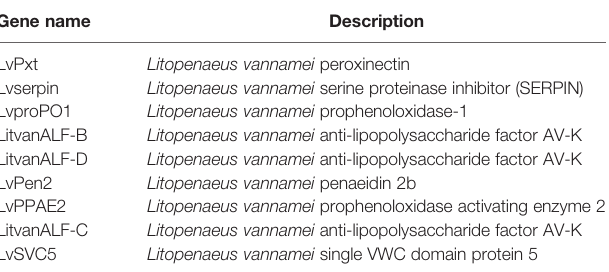
TABLE 5 | The altered genes that were responsible for antimicrobial activity in